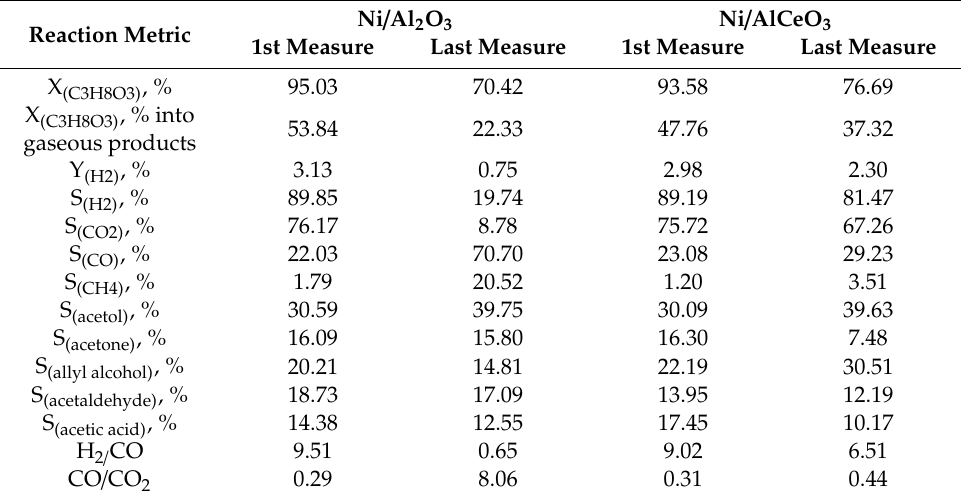
Table 3. Catalytic performance of the Ni / Al 2 O 3 and Ni / AlCeO 3 catalysts during time-on-stream at 600 ◦ C (first and last